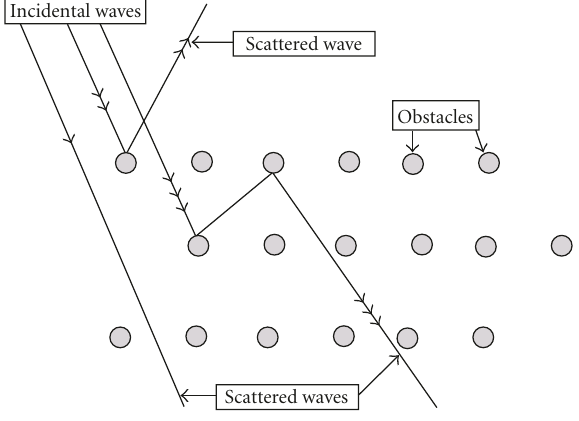
Figure A.2: Illustration of scattered phenomenon.